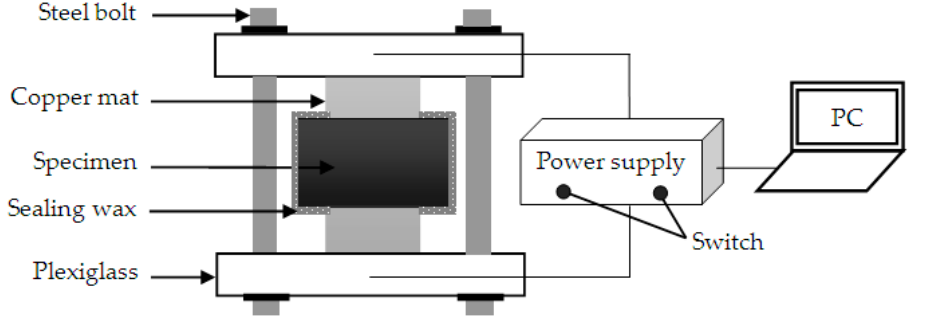
Figure 1. Schematic of test device.